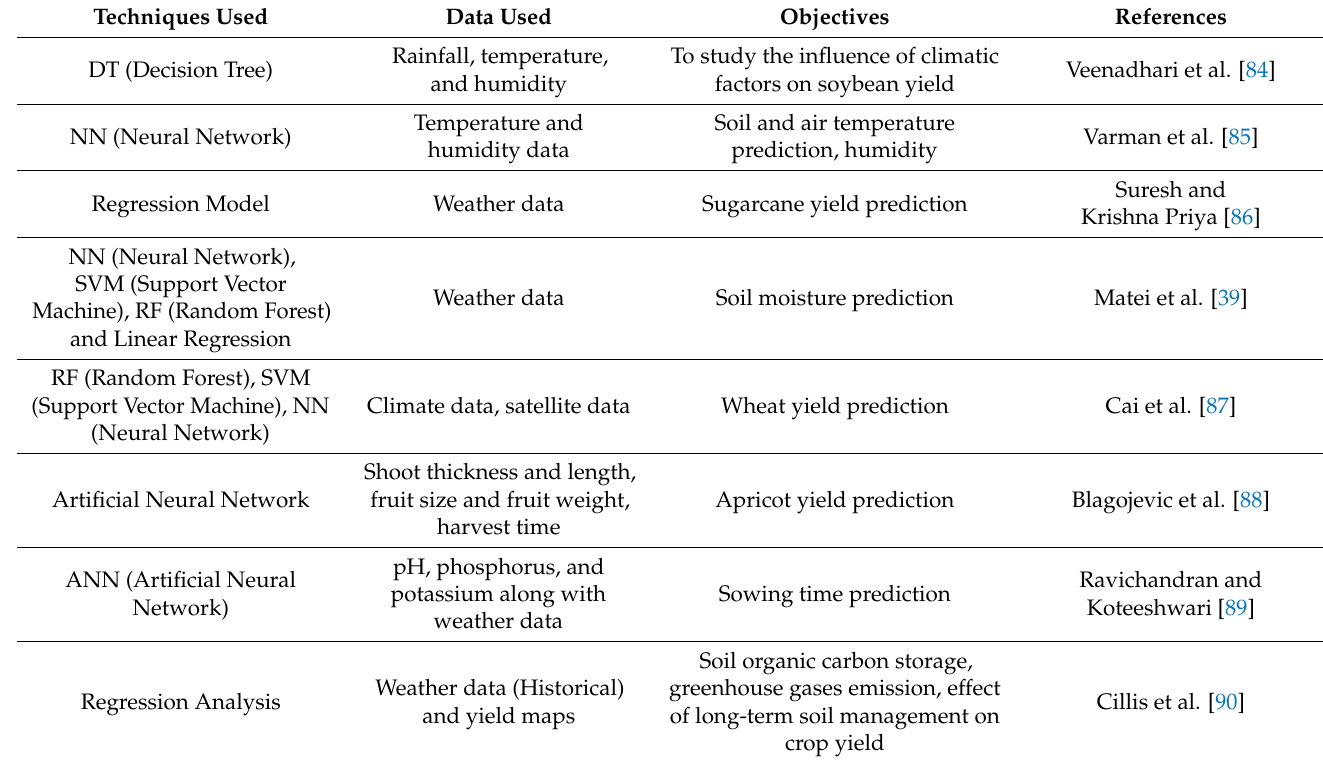
Table 1. Yield prediction and climatic impression on overall yields of crops using smart agricultural data mining